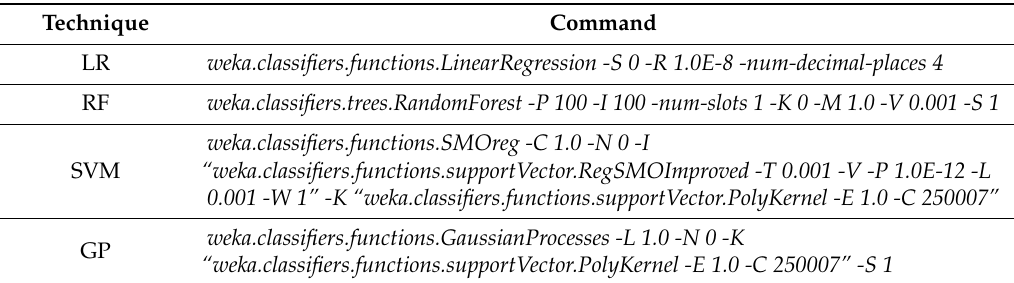
Table 4. WEKA commands for forecasting.